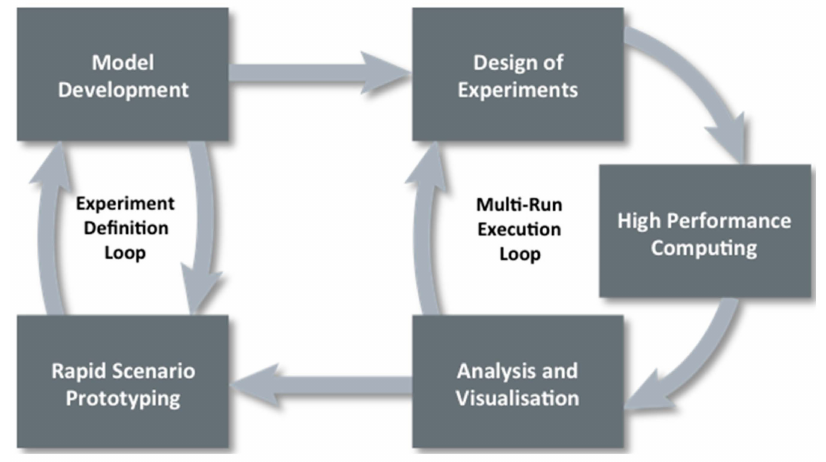
Figure 1. Data farming loop of